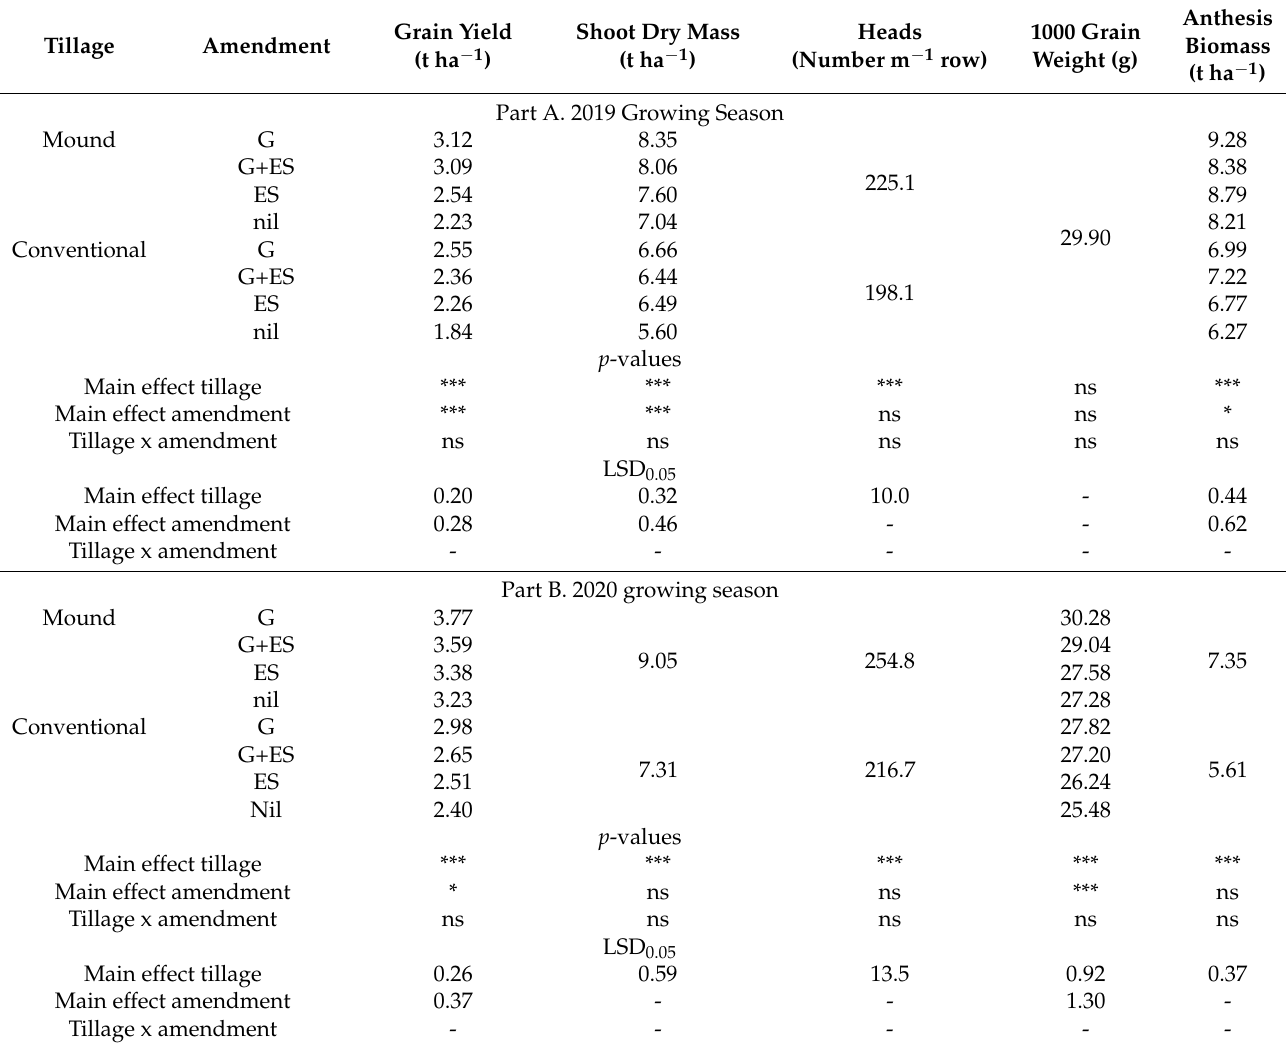
Table 3. Effect on the grain yield and yield components of barley ( H. vulgare ) from tillage and amendment treatments in: (A) the 2019 growing season, and (B) the 2020 season. Values are the average of four measurements, with the standard error of the mean given in brackets. A statistical summary is given at the foot of each